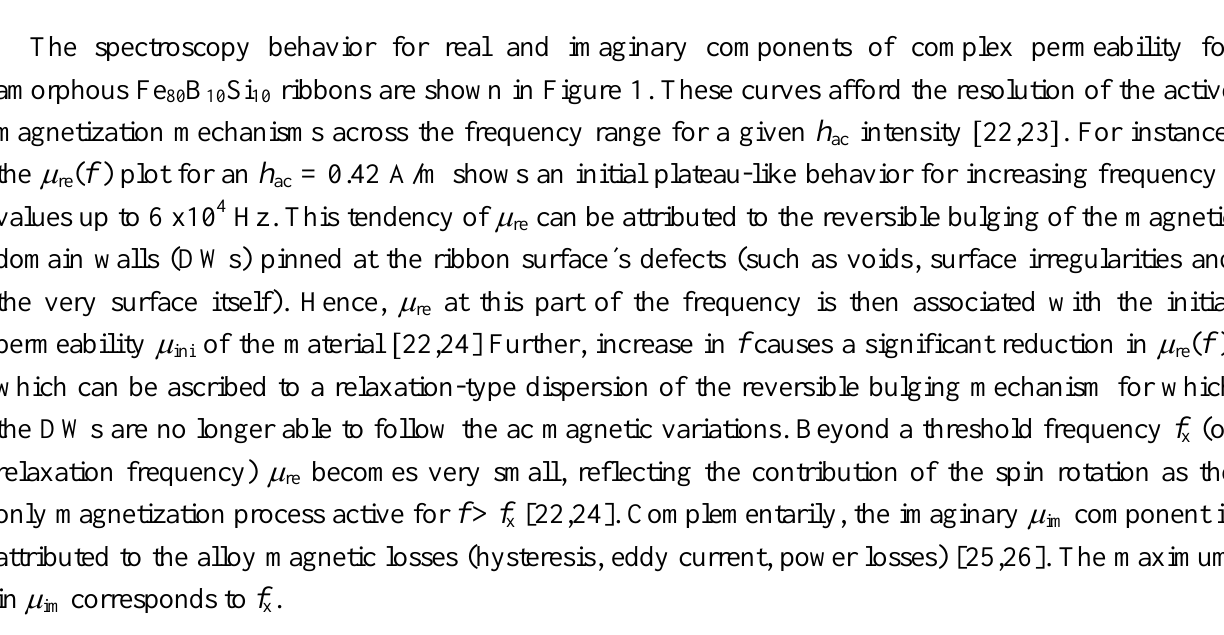
Figure 1. Spectroscopic plots of the complex permeability components for amorphous Fe B Si ribbon at h = 80 10 10 ac